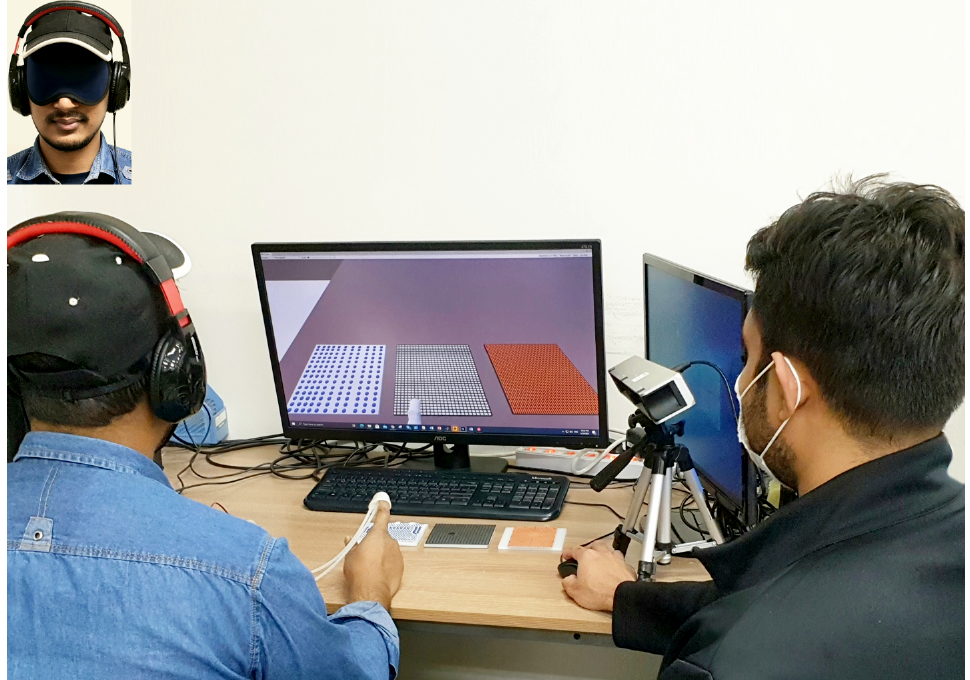
Figure 10. Similarity experiment. The participant compares a real–virtual pair of objects. The operator sitting to the right of the participant replaces the real and virtual samples and records the reported similarity